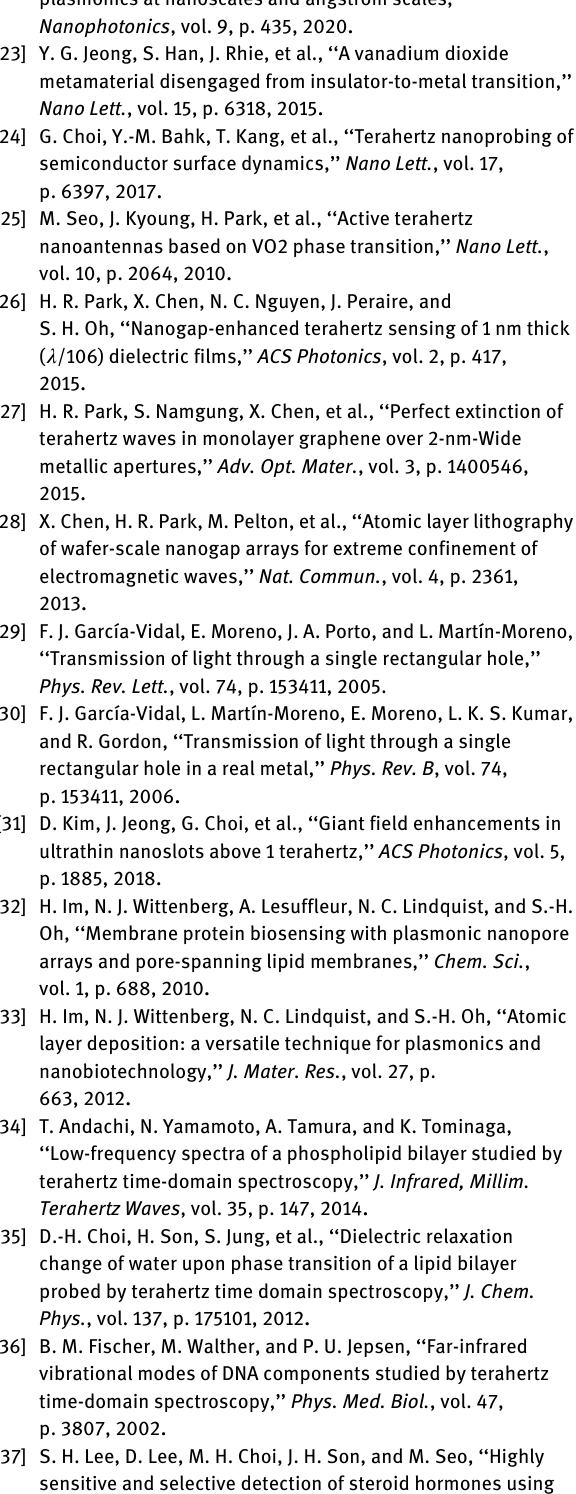
3166 | J. Jeong et al.: Extending the hot spots with terahertz